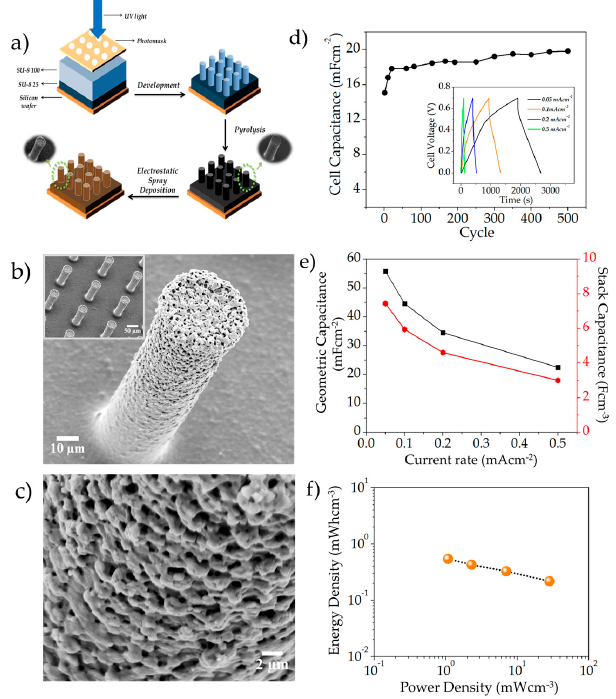
Figure 4. ( a ) Schematic representation of MnO x -ME fabrication process (detailed description in Section 3.3); ( b ) SEM micrograph of a typical MnO x -encrusted carbon micro-pillar; the inset shows MnO x -encrusted micro-pillar arrays; ( c ) zoomed-in view of the microstructure of the electrostatic spray deposition (ESD)-generated MnO x films, ( d ) cyclability of the MnO x -ME electrodes; the inset depicts typical charge–discharge curves of the MnO x -ME at different current rates (0.05–0.5 mA ∙ cm − 2 ); ( e ) geometric and stack capacitances of the MnO x -MEs at different rates; ( f ) Ragone chart of the MnO x -MEs.